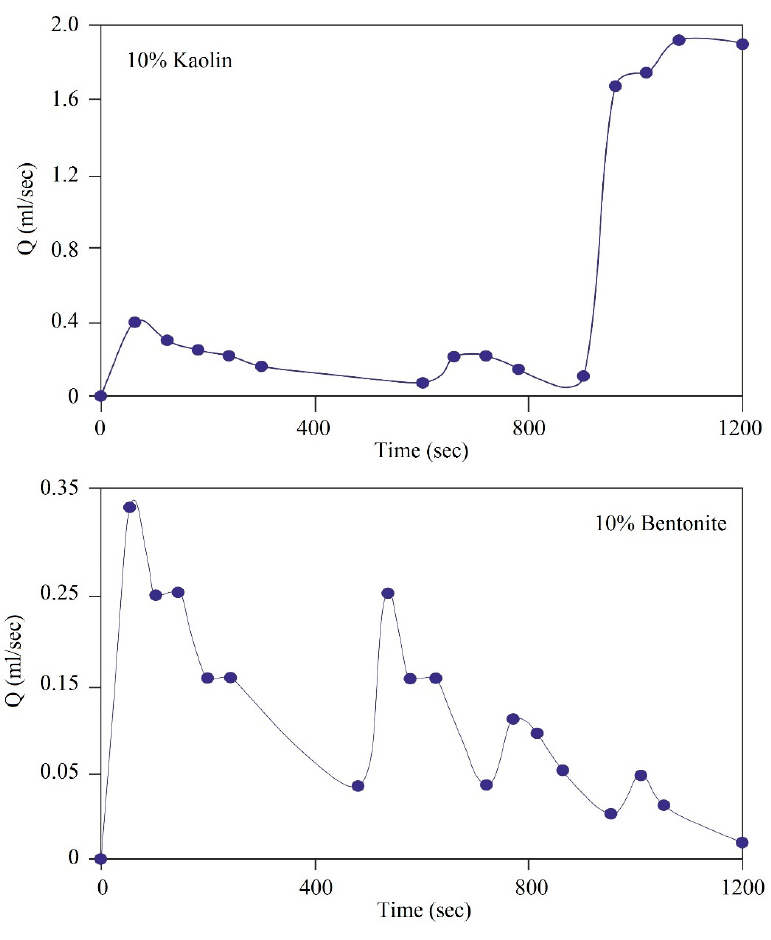
Figure 10. Variation of water flow in a clayey soil sample with additives.